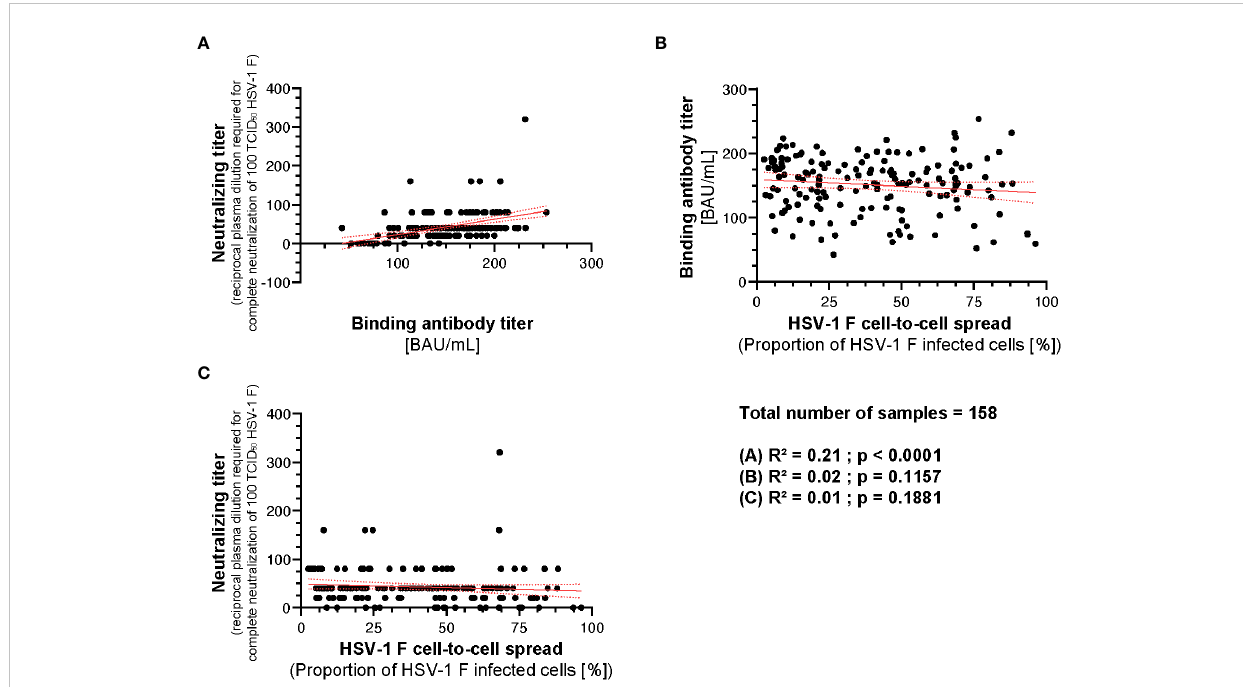
FIGURE 8 Correlation between HSV-1 IgG ELISA, neutralizing antibody titers and cell-to-cell spread inhibition. A correlation analysis was performed to investigate potential correlation between HSV-1 binding IgG titers, neutralizing titers, and cell-to-cell spread inhibition of 158 plasmas from the retrospective survey cohort was performed. (A) The correlation between the HSV-1 IgG ELISA binding antibody titers and neutralizing antibody titers, (B) HSV-1 IgG ELISA binding antibody titers and the level of cell-to-cell spread inhibition and (C) neutralizing antibody titers and the level of cell-to- cell spread inhibition was calculated using Spearman ’ s rank correlation